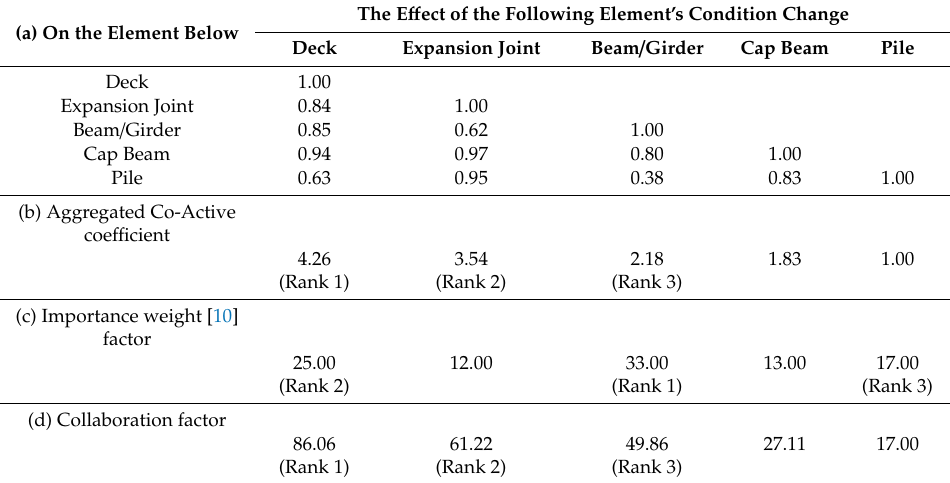
Table 7. Co-Active prioritization parameters in ‘RC110’ group.